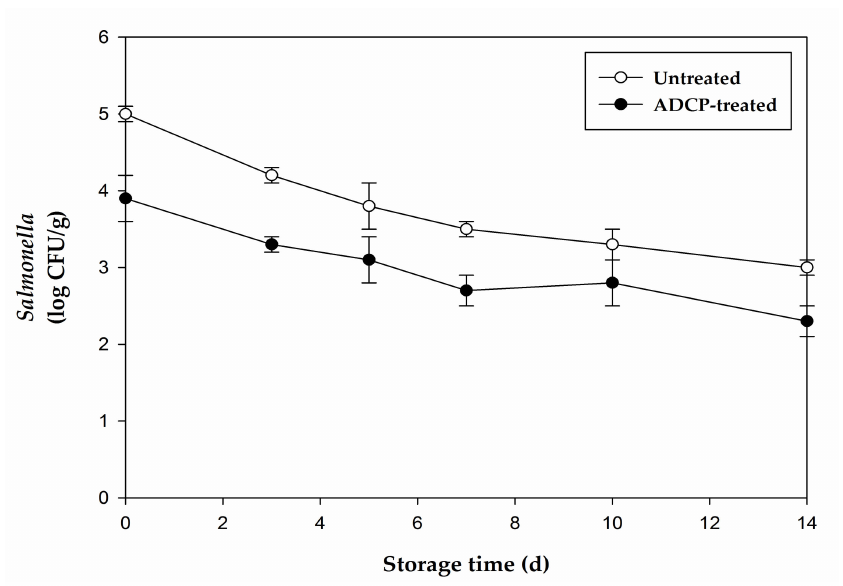
Figure 2. Effects of atmospheric dielectric barrier discharge cold plasma (ADCP) treatment on the growth of Salmonella in chicken breast salad during storage at 4 ◦ C. Error bars represent standard deviation ( n = 4).